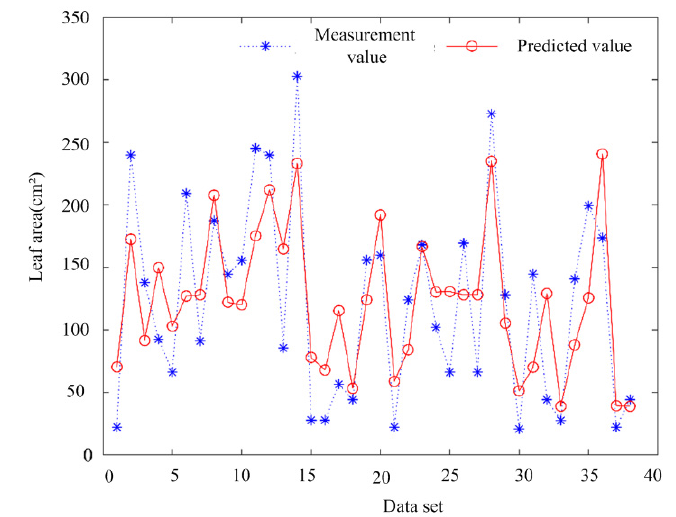
Figure 14. Test set data fitting diagram.